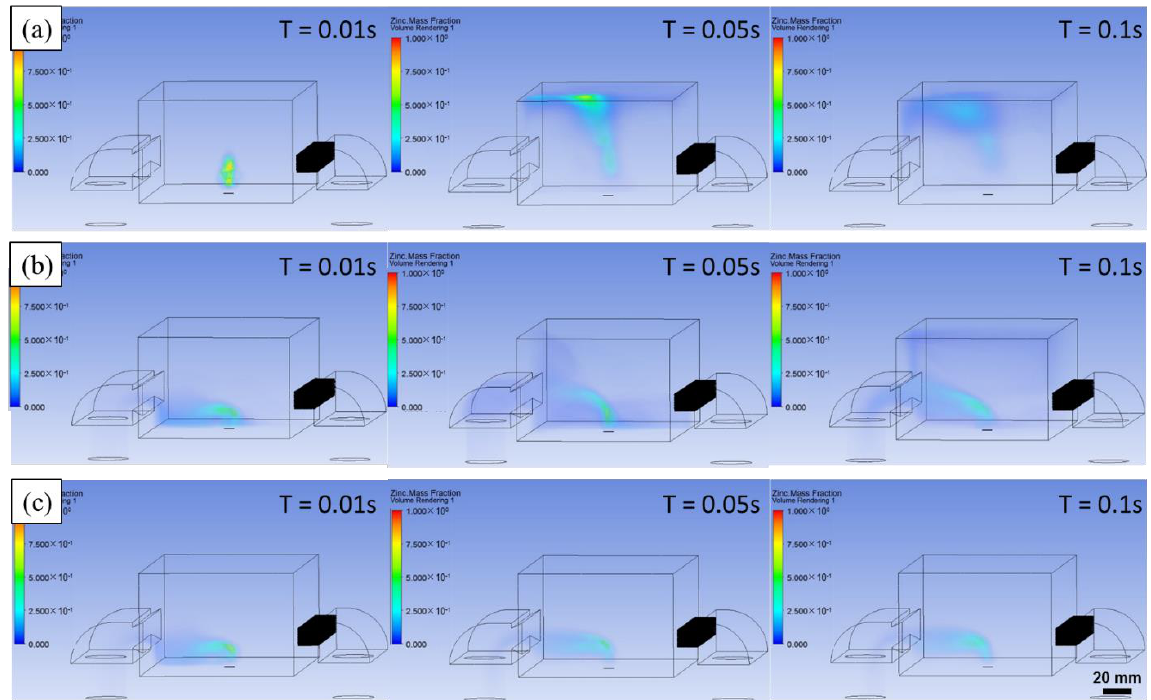
Figure 9. Effect of shielding gas flow on the evaporation fume, ( a ) no shielding gas flow; ( b ) insufficient shielding gas flow; ( c ) adequate shielding gas flow.